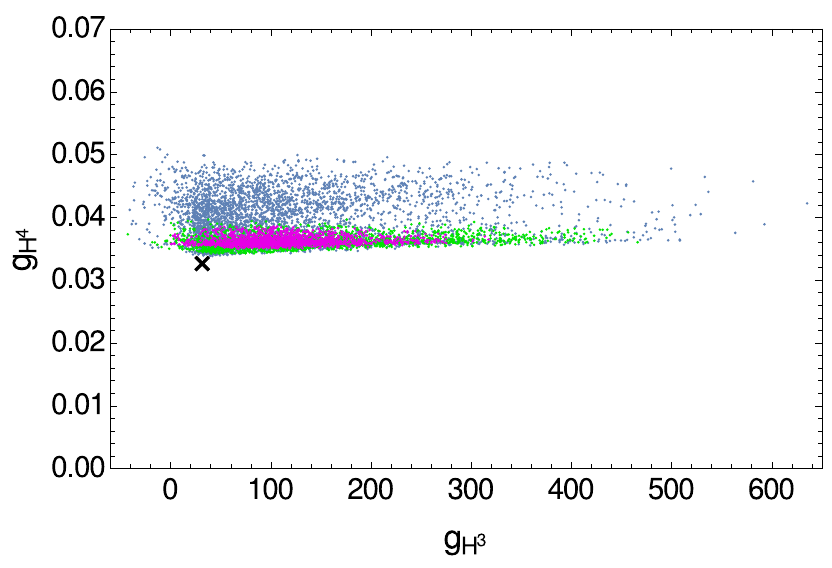
Figure 8 . Scatter plot of g H 4 versus g H 3 . The notation for the colours of the points is the same as in figure 4. The black cross indicates the values of g H 4 and g H 3 in the